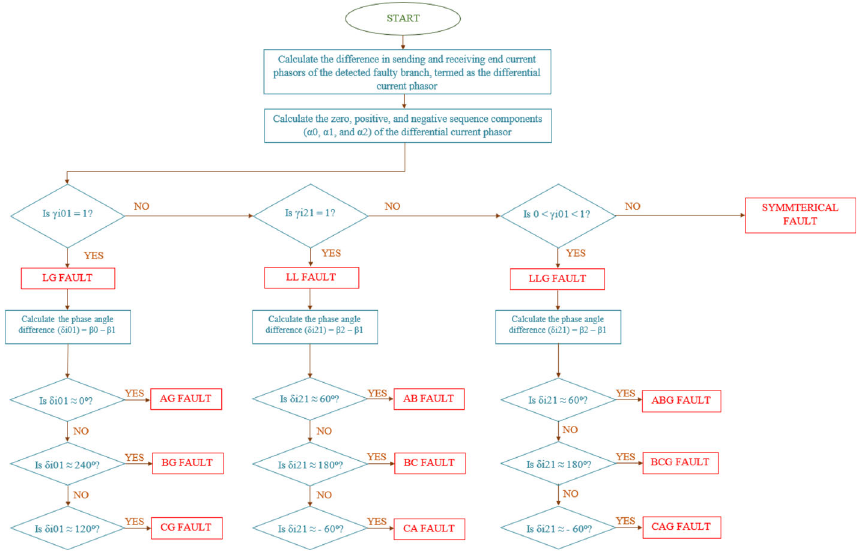
Fig. 6 Fault Classification